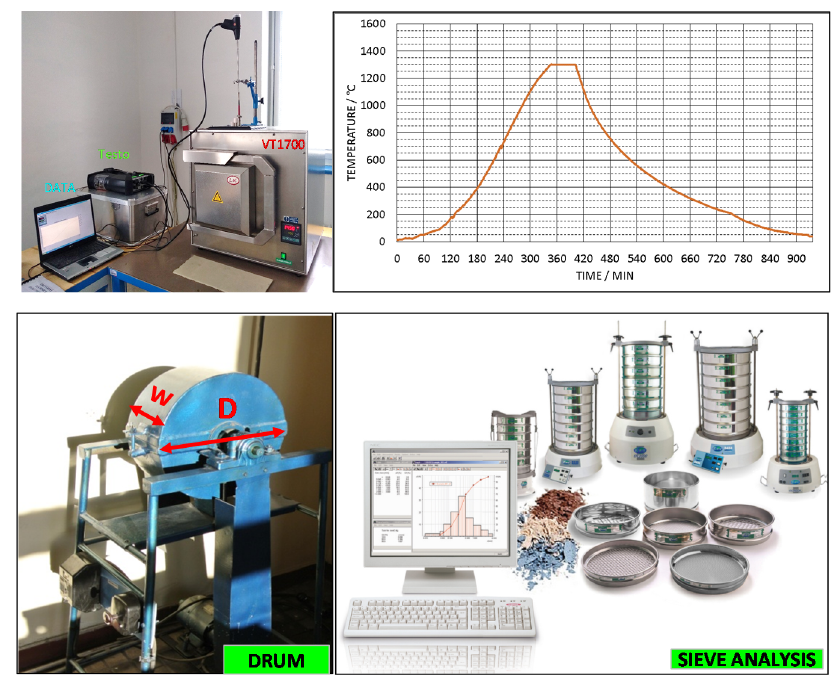
Figure 4. High-temperature stability test overview.